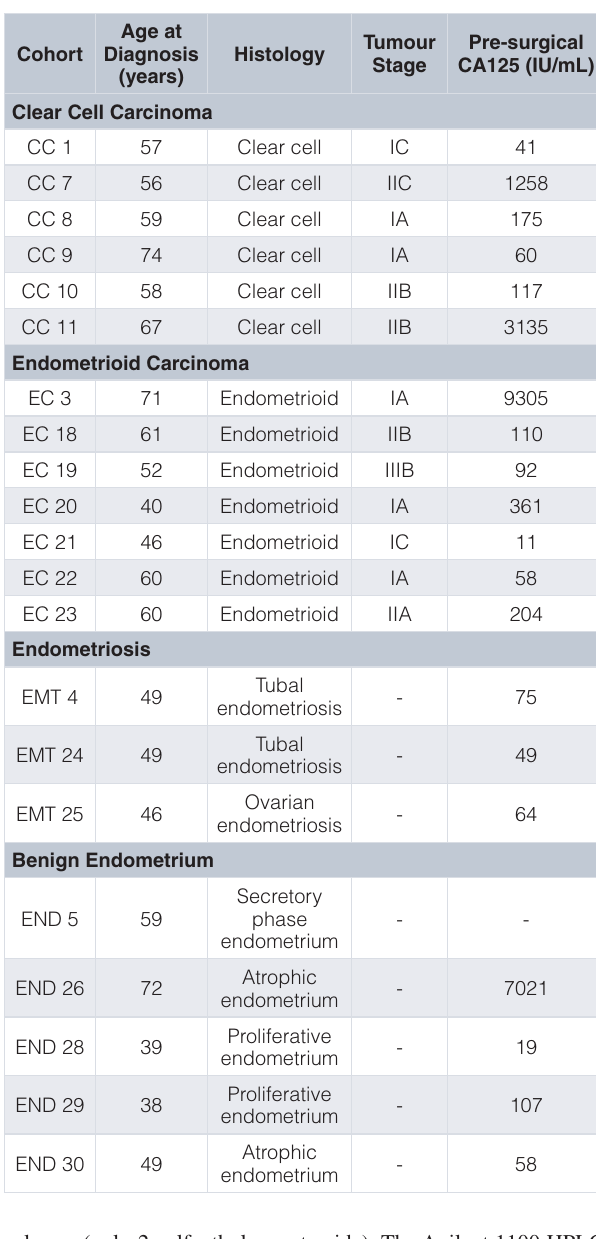
converting enzyme inhibitor (American Protein Company, CA) after every biological sample.